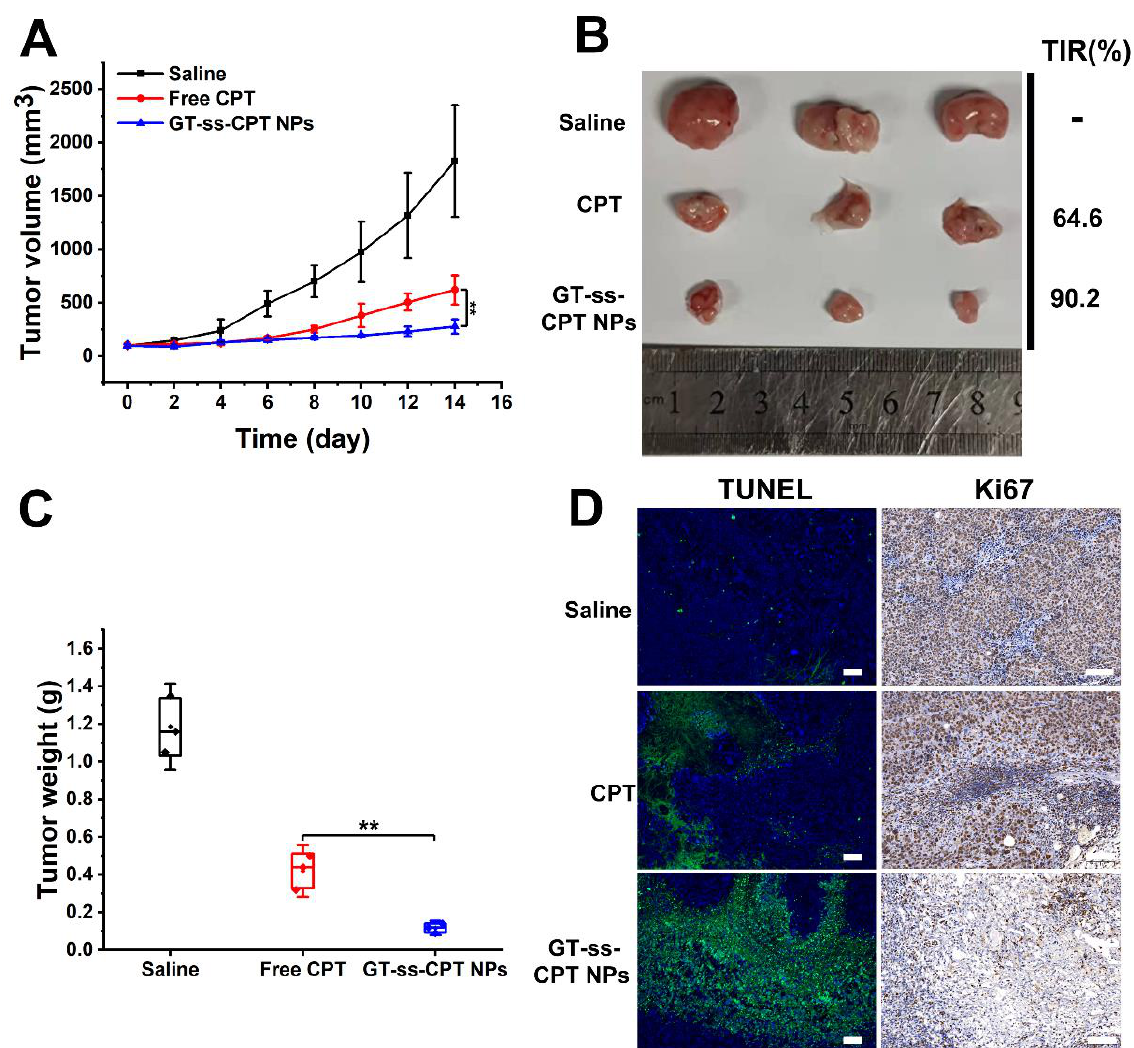
Figure 6. In vivo antitumor effects of GT-ss-CPT NPs against hepatoma carcinoma. ( A ) Tumor volume changes during the therapeutic period ( n = 3). ** p < 0.01 (ANOVA test). ( B ) H22 tumors separated from mice treated with saline, free CPT, and GT-ss-CPT NPs at the end of therapy and the corresponding TIRs. ( C ) Tumor weight from mice treated with saline, free CPT, and GT-ss-CPT NPs at the end of therapy ( n = 3). ** p < 0.01 (ANOVA test). ( D ) Representative TUNEL and Ki-67 immunohistochemical staining of the tumor tissues. Scale bar: 100 µm.